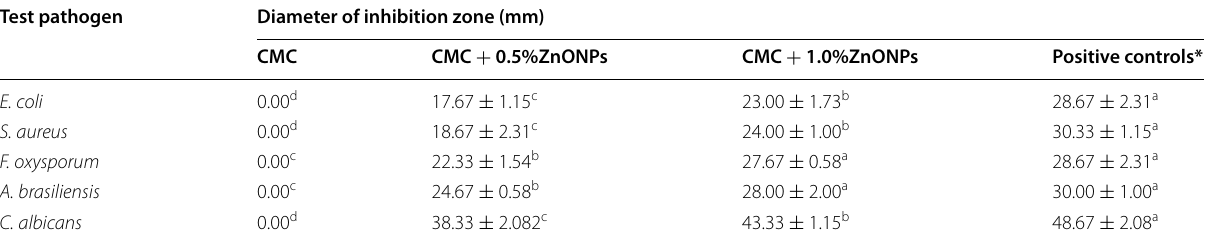
*Azithromycin and ketoconazole were used as positive controls at a concentration of 100 μg mL − 1 Calculated mean is for triplicate measurements from three independent experiments a–d Means with different superscripts in the same row are considered statistically different (LSD test, P